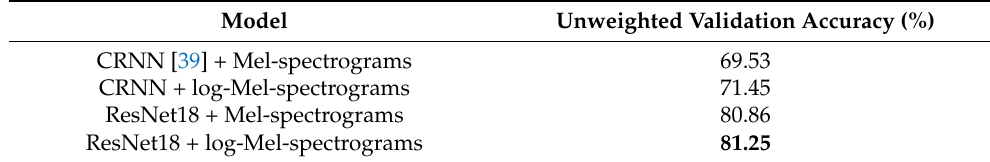
Table 2. Comparison of the teacher model using different methods.